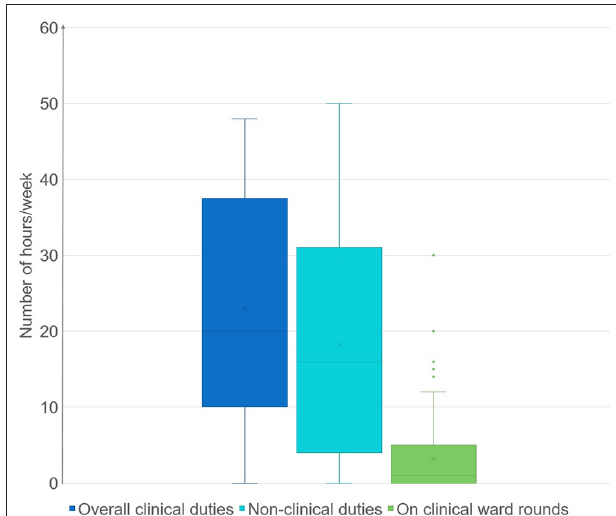
FIGURE 1 | Time clinical pharmacists spent on each